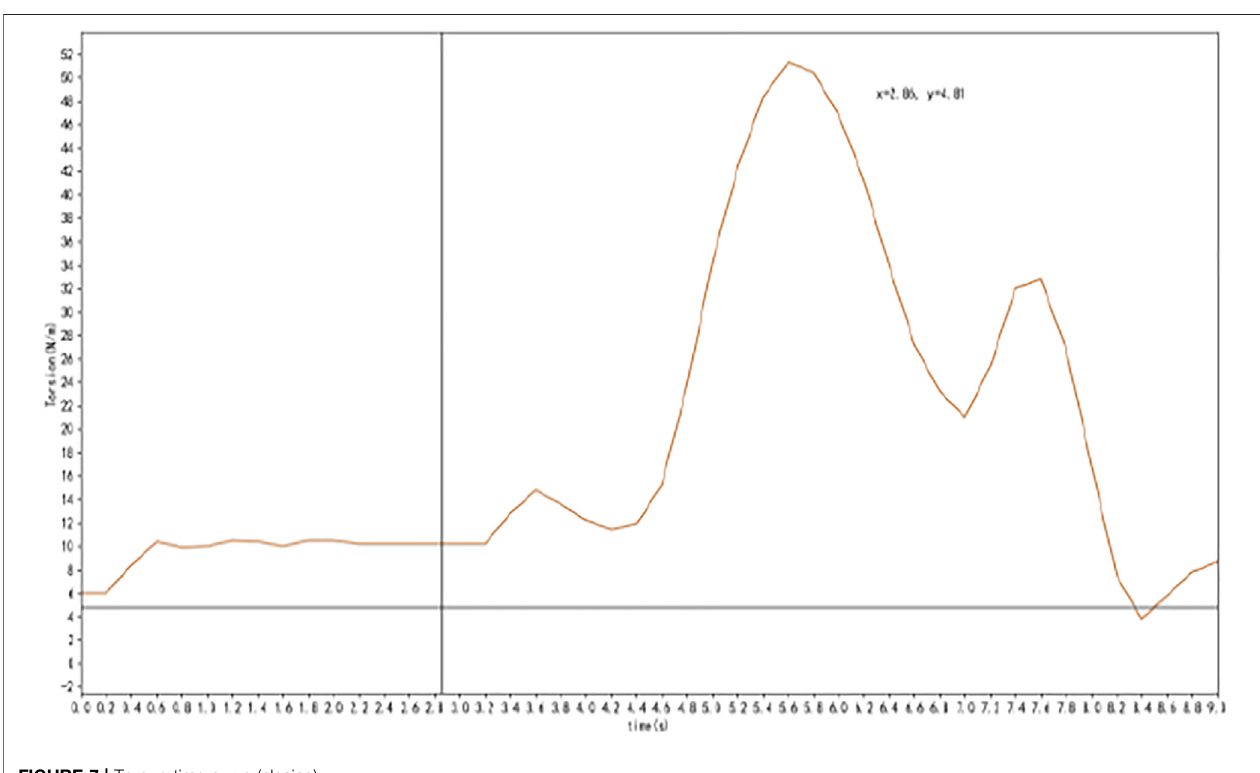
FIGURE 7 | Torque-time curve (closing).